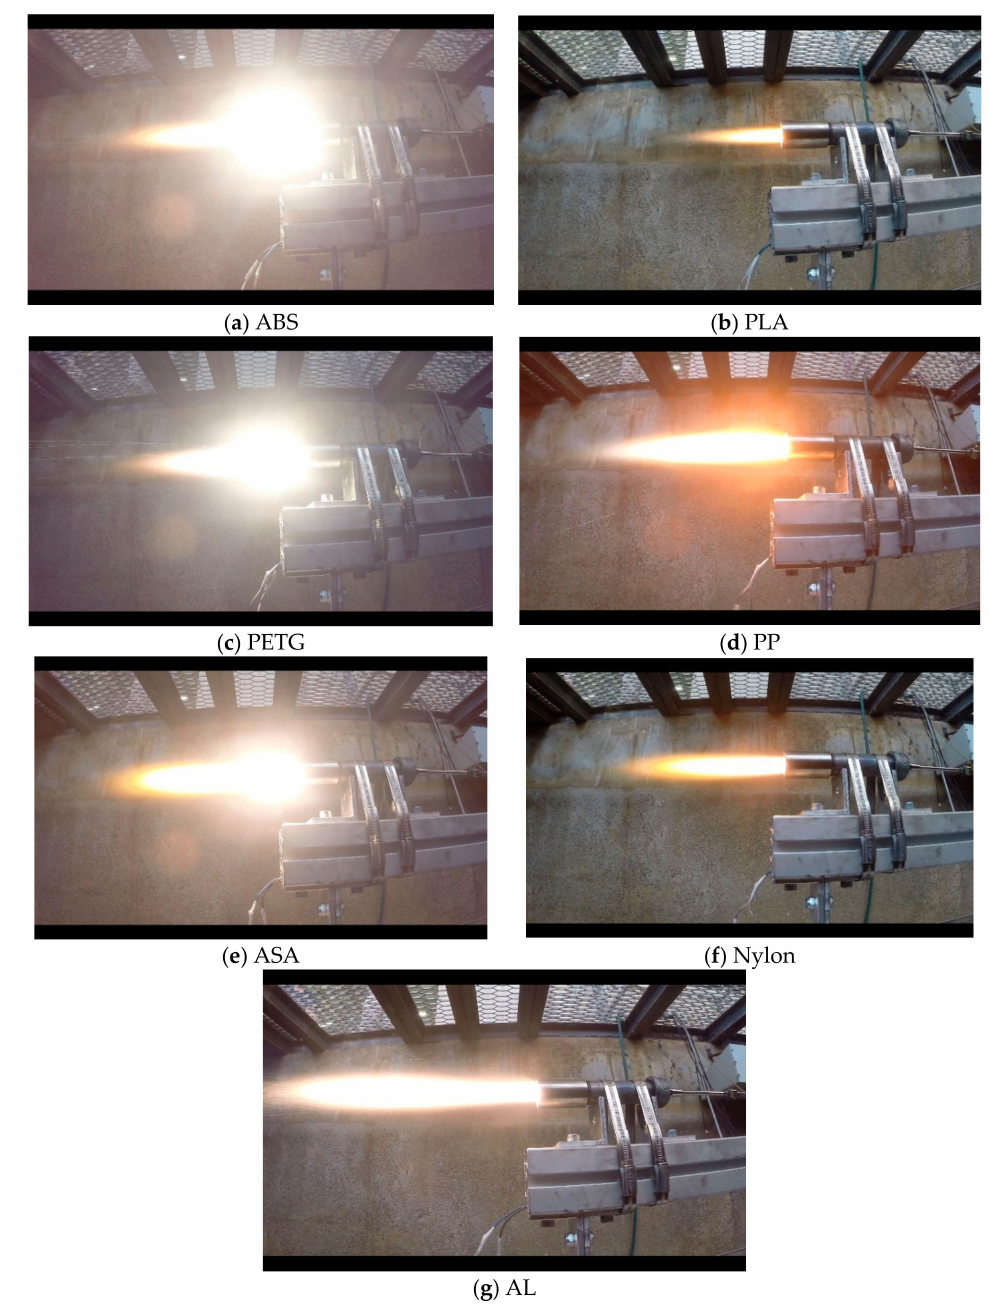
Figure 3. Small-scale testing of fuel grains 3D-printed from di ff erent fused deposition manufacturing (FDM)